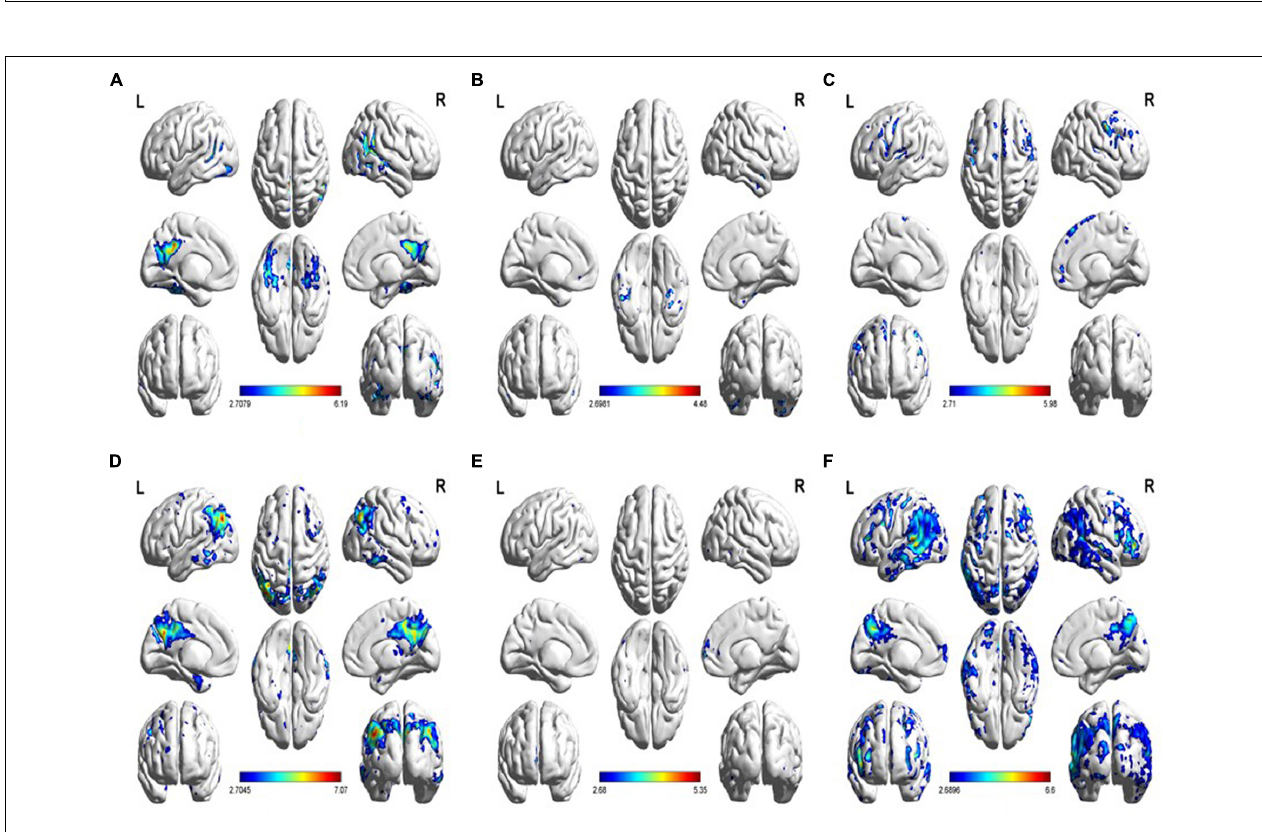
FIGURE 3 | (A) Increased tau uptake in the MMSE-mild subgroup relative to the HC group. (B) Increased tau uptake in the MMSE-moderate subgroup relative to the MMSE-severe subgroup. (C) Increased tau uptake in the MMSE-severe subgroup relative to the MMSE-moderate subgroup. (D) Decreased FDG uptake in the MMSE-mild subgroup relative to the HC group. (E) Decreased FDG uptake in the MMSE-moderate subgroup relative to the MMSE-severe subgroup. (F) Decreased FDG uptake in the MMSE-severe subgroup relative to the MMSE-moderate subgroup ( p < 0.01).